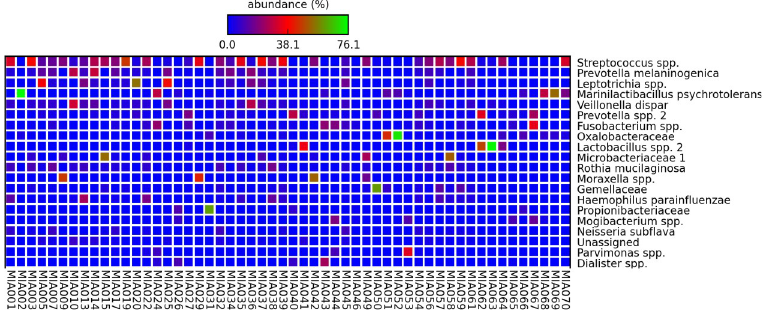
Fig 1. Top 20 OTUs identified from 54 patients, with the highest mean abundance (%) being the topmost. The colours indicate the abundance of OTUs in each patient, with blue regarded as low abundance, red as moderate abundance and green as high abundance.